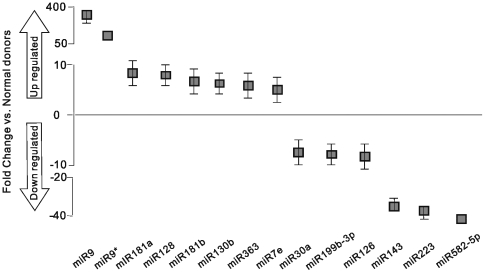
Differential expression of miRNAs in ALL patients.Box plots (median and interquartile range) show the distribution of fold change of expression in ALL patients compared with normal donor samples.